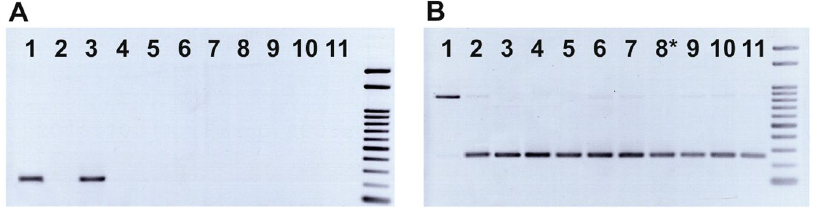
Figure 1. Expected amplification given by A . ruthenus positive primer 247_ARp ( A ) and A . ruthenus negative primer 247_ARn ( B ) in combination with common primer 247_uni. Amplification of a 750 bp band was occasionally provided by A . ruthenus negative primer 247_ARn, but this amplification was not species-specific. 1 = A . ruthenus ; 2 = H . huso ; 3 = bester; 4 = A . baerii ; 5 = H . dauricus ; 6 = A . schrenckii ; 7 = A . gueldenstaedtii ; 8 = A . stellatus ; 9 = A . persicus ; 10 = A . mikadoi ; 11 = A . transmontanus . * Positive amplification was obtained only in 57,5% samples of A . stellatus .